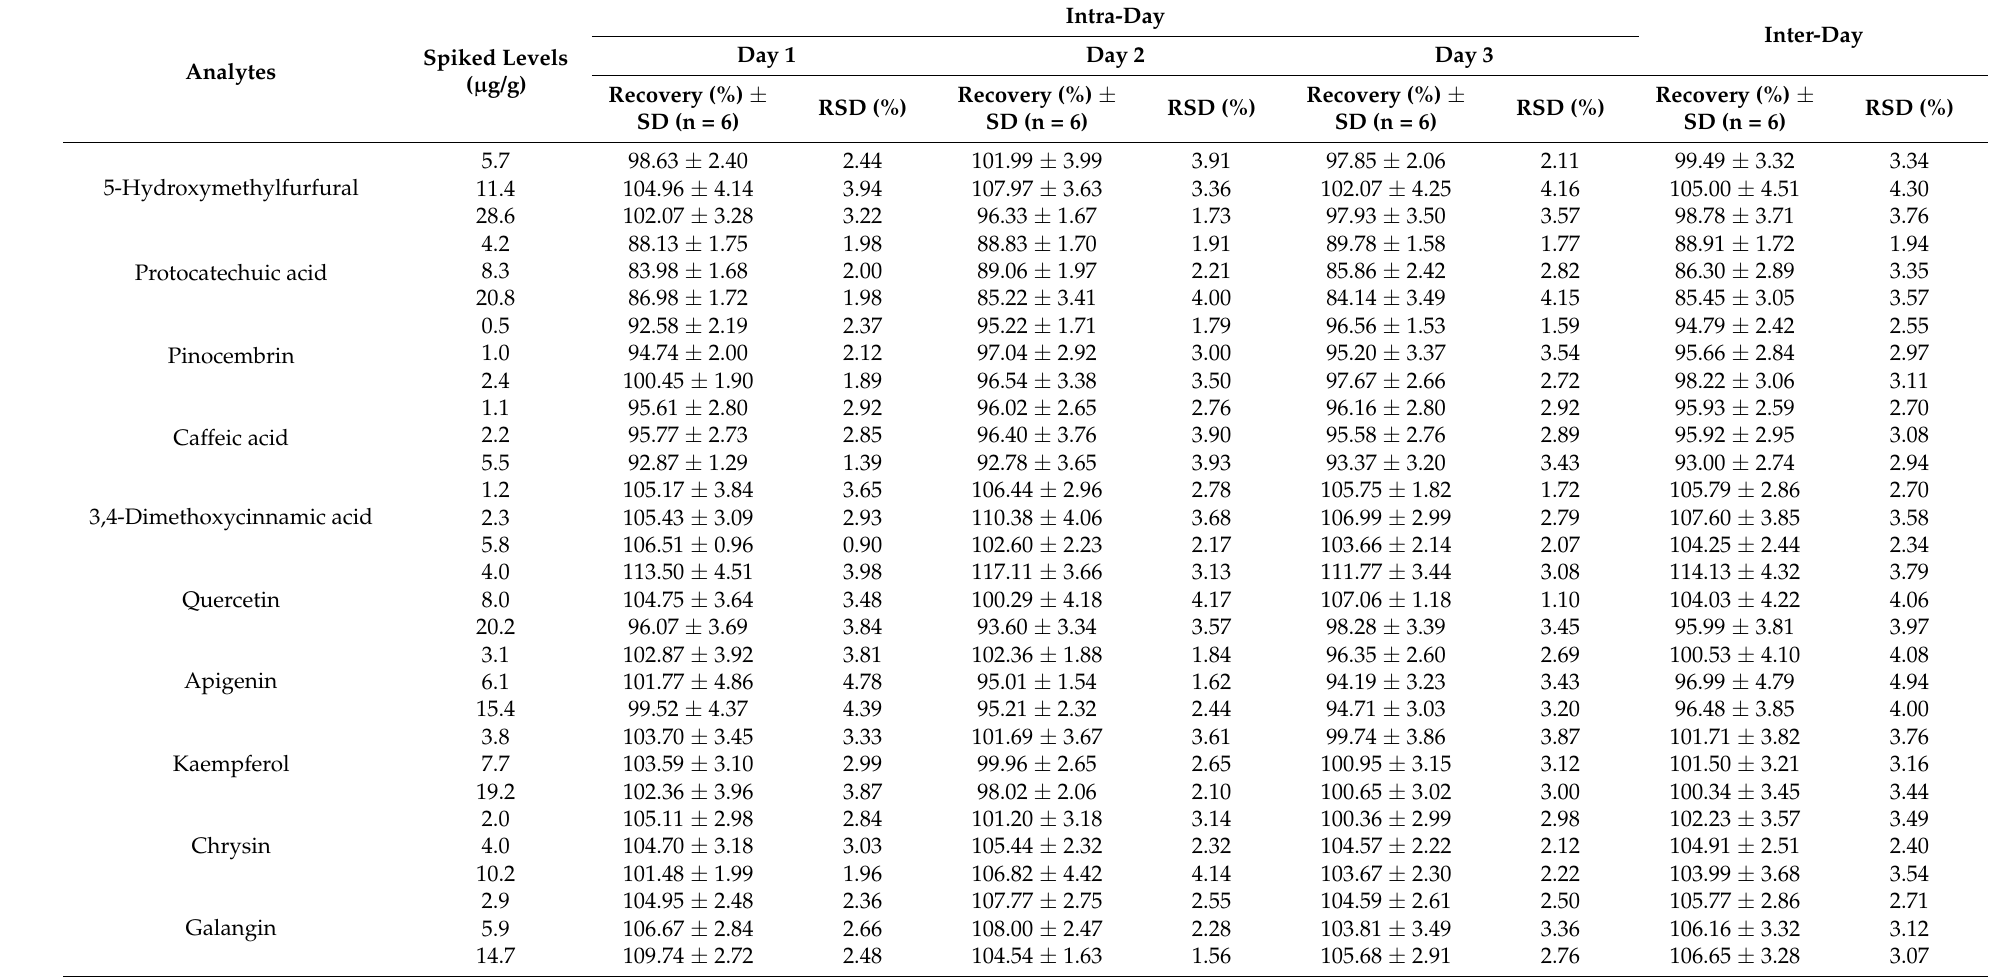
Table 2. Accuracy and precision in spiked honey sample at three spiked